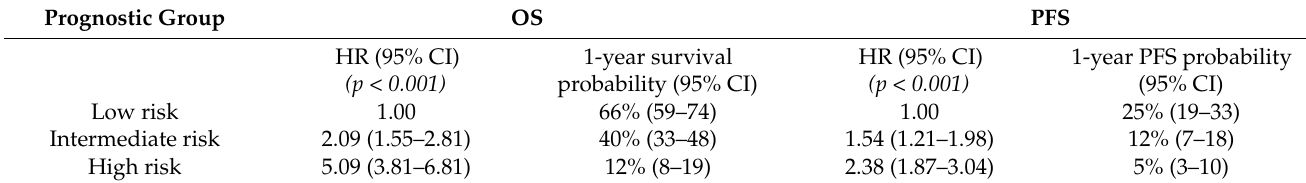
Table 2. Effect size and 1-year survival probability for gradient-boosted machine (GBM) stratified prognostic groups on validation cohort within IMvigor211.